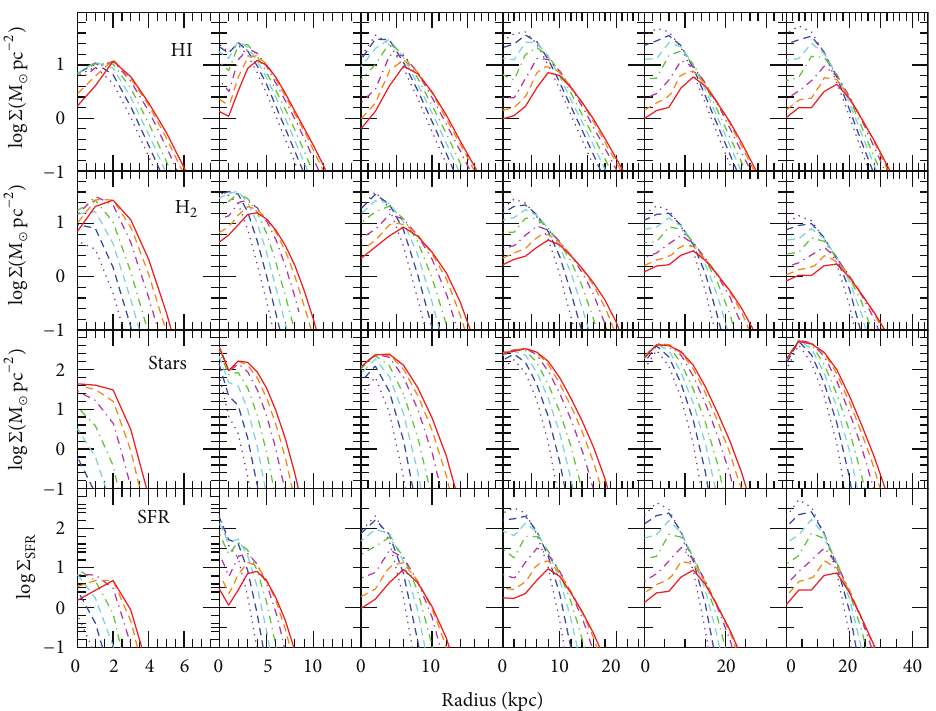
Figure 5: Evolution with redshift of the surface density of diffuse gas, Σ top, and middle-bottom rows, and the star formation rate, Ψ , in M ⊙ Gyr −1 pc −2 , in the bottom one. All in logarithmic scale. Each column shows the results for a theoretical galaxy of the Table 1, from the galaxy, with 𝑉 max = 78 km s −1 , to the most massive one for 𝑉 max = 290 km s −1 . Each line corresponds to a different redshift: purple, blue, cyan, green, magenta, orange, and red for 𝑧 = 5, 4, 3, 2, 1, 0.4, and 0, respectively.